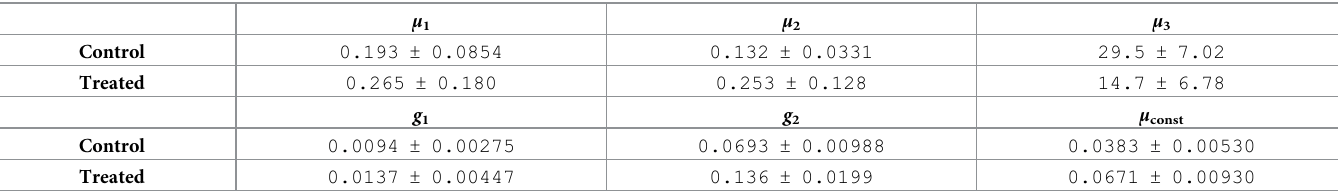
Table 1. Maximum likelihood estimates for the